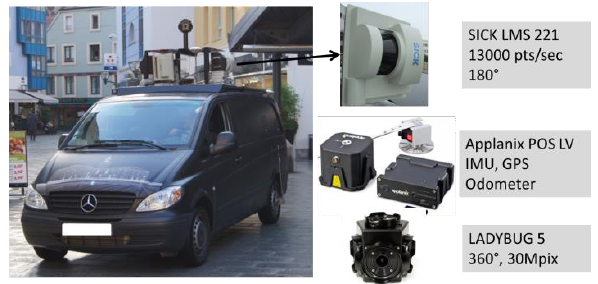
Figure 1: Siradel mobile mapping system